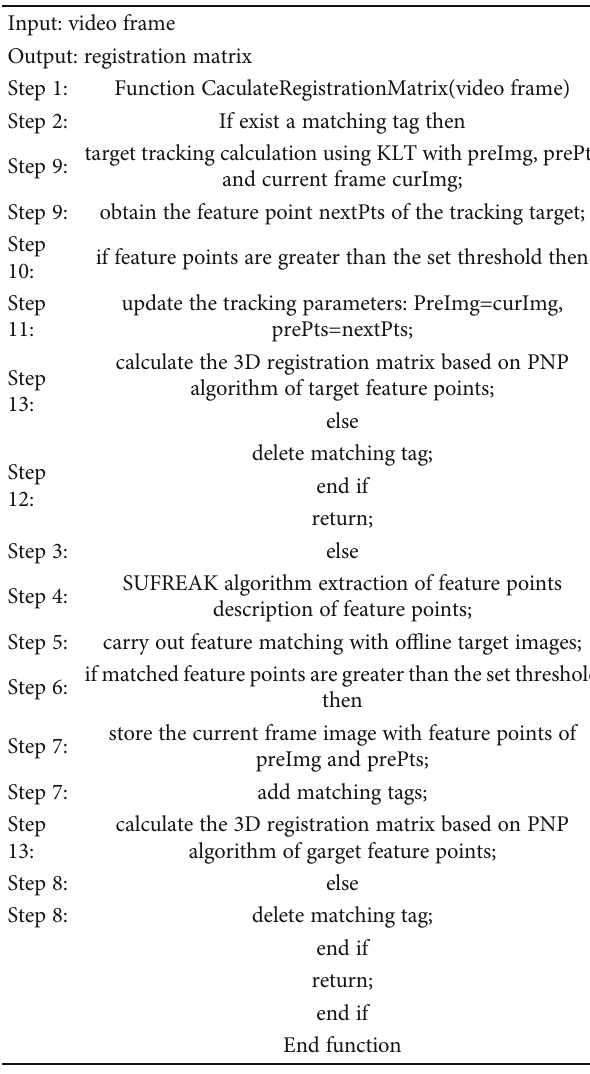
Table 1: Pseudocode of 3D registration